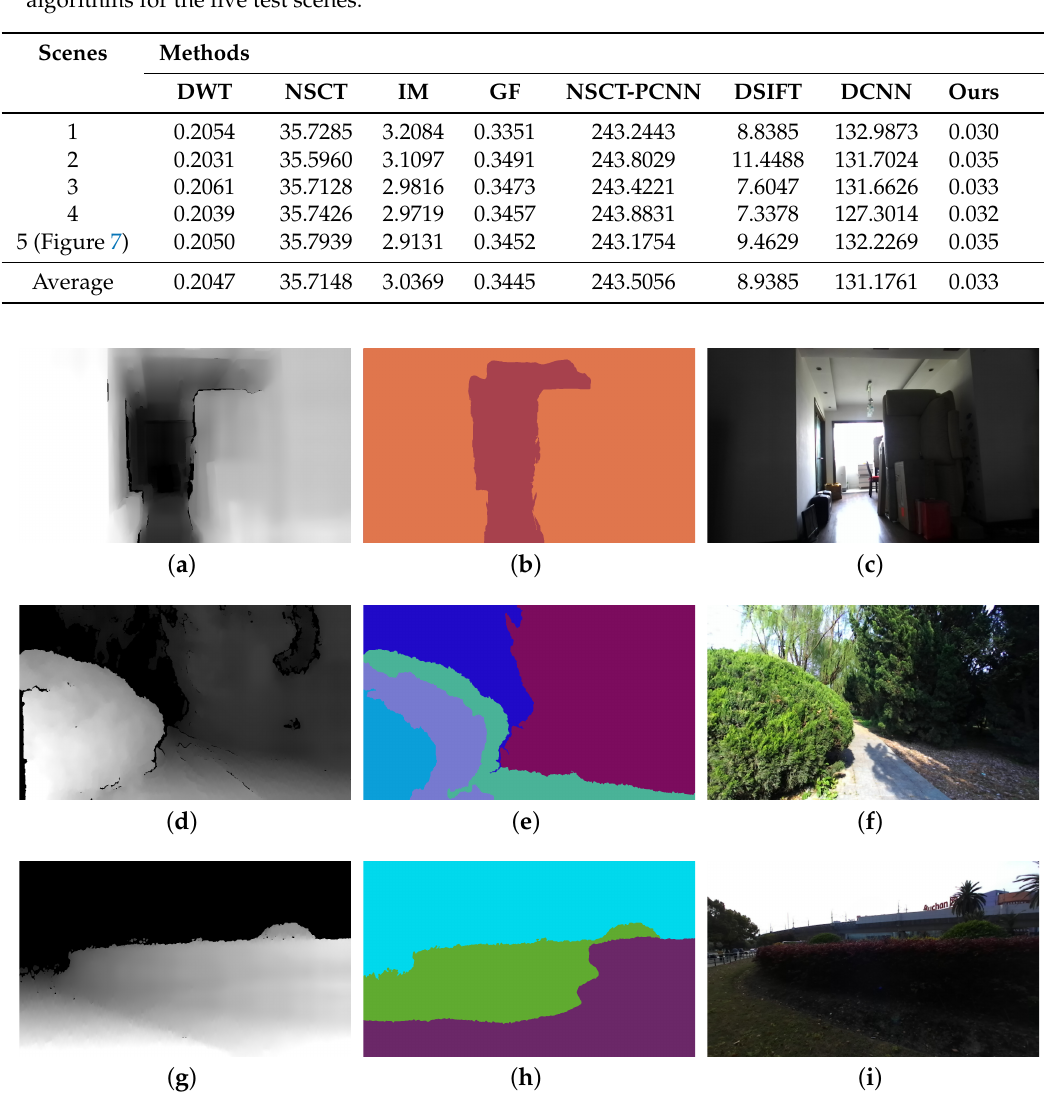
Figure 8. ( a , d , g ) Depth maps obtained via the use of a ZEDstereo camera. ( b , e , h ) In-focus image block regions determined by segmenting depth maps. ( c , f , i ) Corresponding all-in-focus colour